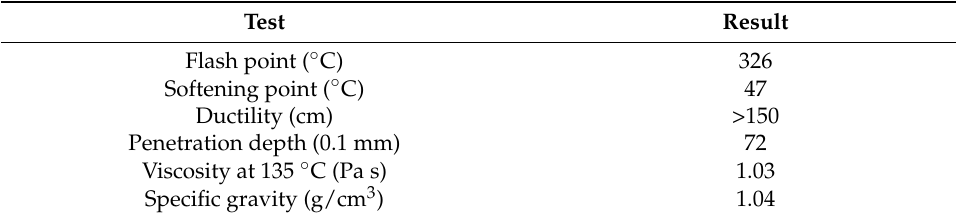
Table 1. Properties of asphalt binders.